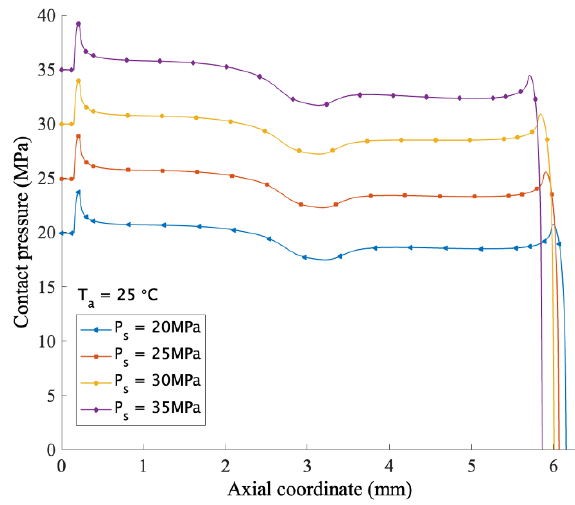
Figure 2. Static contact pressure distribution, outstroke.